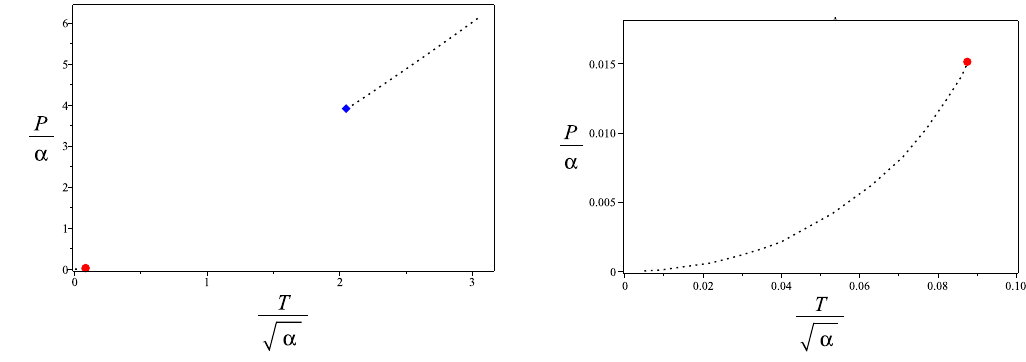
Figure 17 . Left : it was (cid:12)xed (cid:22) Q = 0 : 67. The red point, at the left, is the RN-AdS-like critical point. The second blue point, at the right, is the hairy critical point. The dotted lines indicate the coexistence line. Right : magni(cid:12)cation near the RN-AdS-like critical point and its coexistence line.